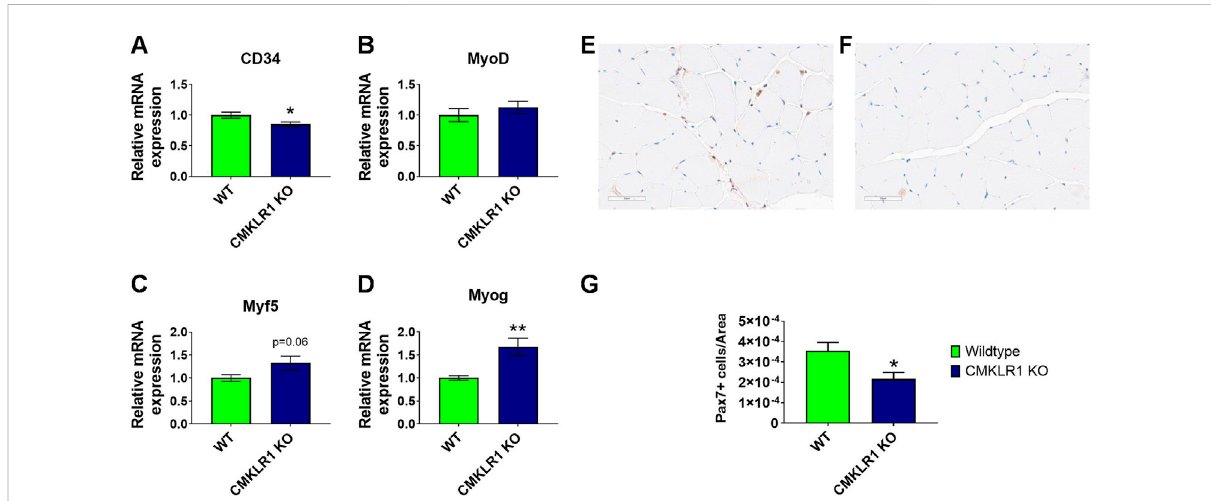
FIGURE 3 CMKLR1 inhibition modulates myogenesis Relative mRNA levels of myogenesis markers in mouse gastrocnemius complex of wild type and CmklR1KOmice.CD34asmarkerforquiescence (A) ,MyoD (B) andMyf5 (C) asearly-stagemarkersofmyogenicdifferentiation,andmyogenin (D) as a late-stage marker. Representative section with PAX7 staining of a control animal (E) and a CMKLR1 knockout mouse (F) with machine-learning- based segmentationand classi fi cation ofPAX7 positive (brownish) and negativenuclei (blue). Quanti fi cation with groupcomparison (G) .Values are expressed as means ± SEM; *: p < 0.05, **: p < 0.01 versus wild type mice by unpaired t -test; n = 8 – 10 per